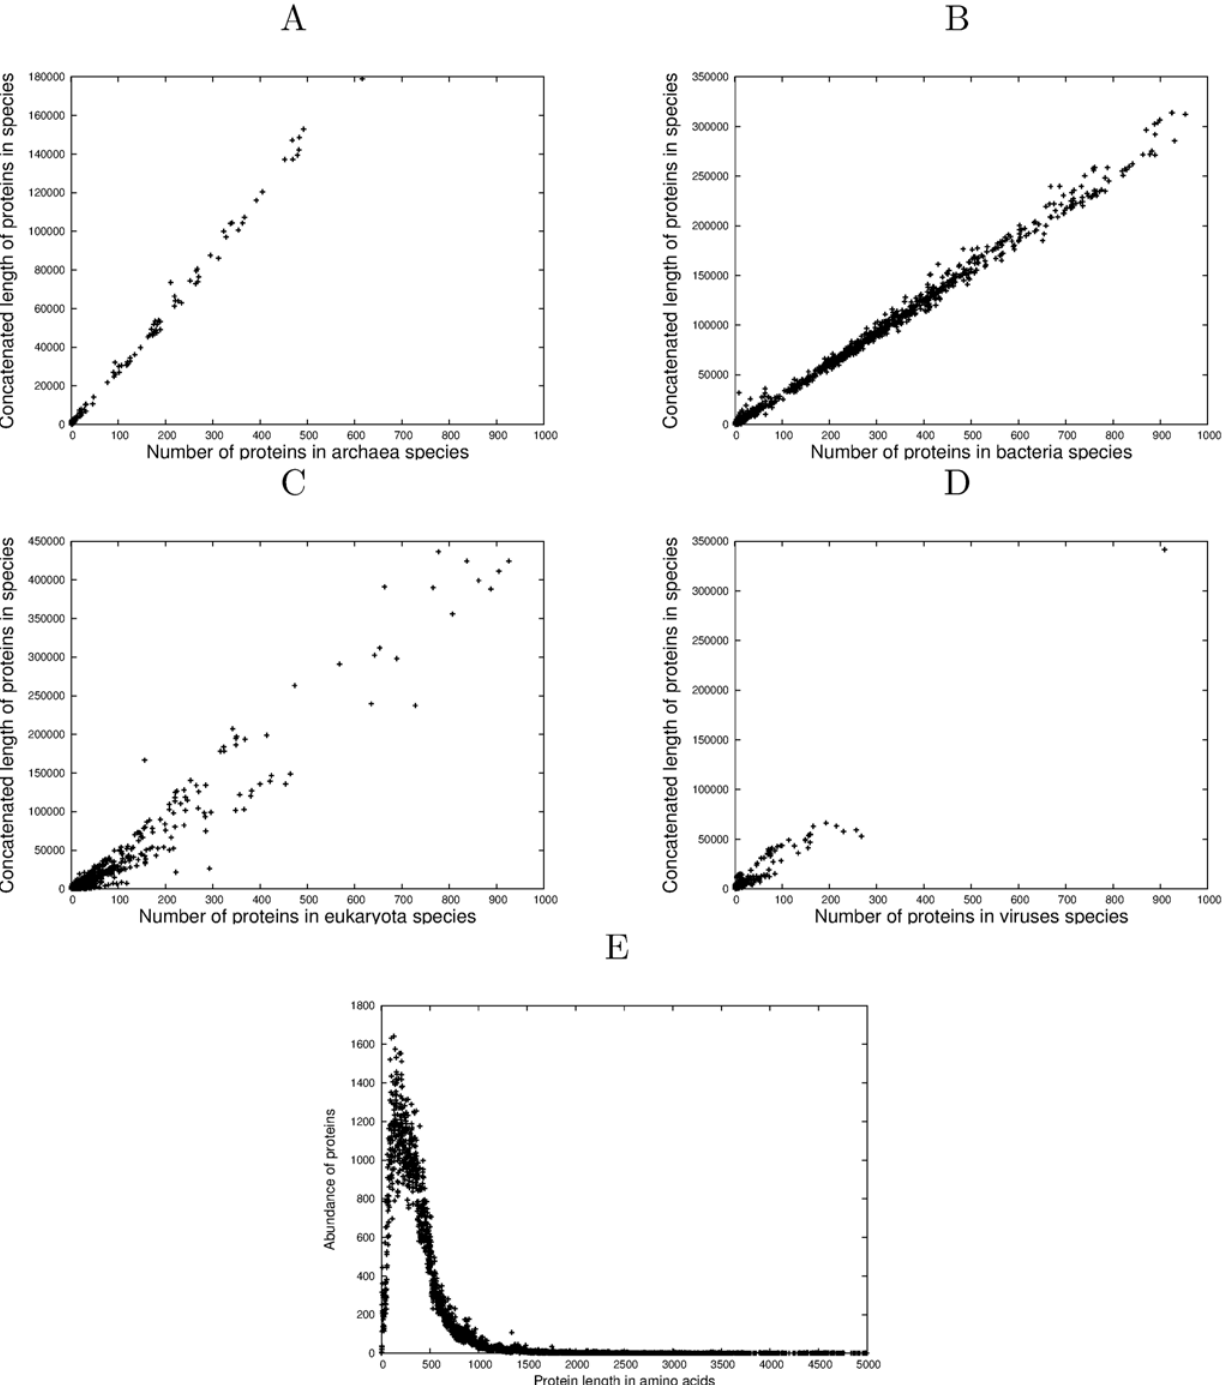
Fig 6. Average protein lengths in the Four Domains of Life and complete distribution. A Average length of proteins for archaean species. B Average length of proteins for bacterial species. C Average length of proteins for eukaryotic species. D Average length of proteins for viral species. E The length distribution of all proteins in the analyzed SwissProt database, release